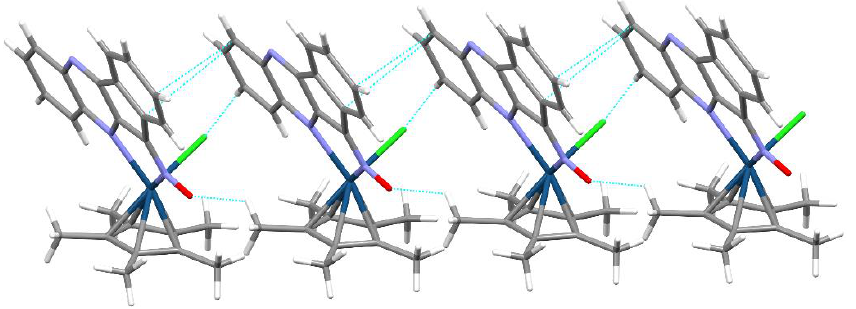
Figure 2. Fragment of the crystal structure of compound 1 showing the homochiral chain oriented along axis a . Short contacts are shown as dashed lines.